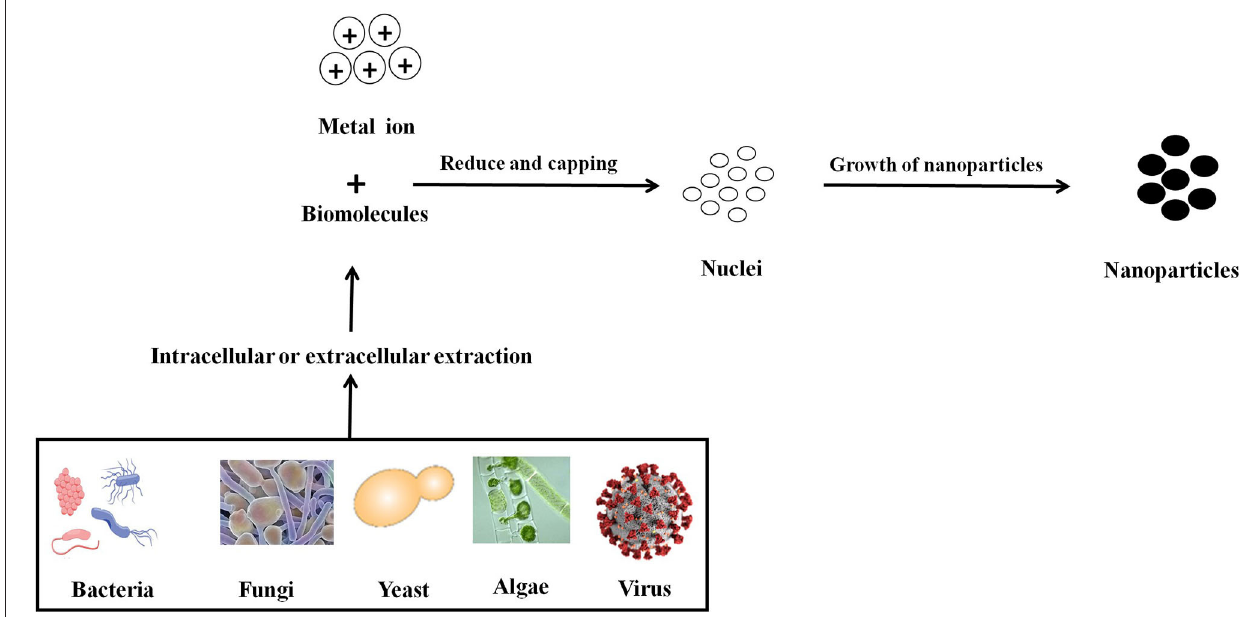
FIGURE 2 | Mechanistic representation of the synthesis of nanoparticle by microbes. Formation of nanoparticles by microbes involves metal capture, enzymatic reduction, and capping. Metal ions are first trapped on the surface or inside of the microbial cells and then reduced to nanoparticles in the presence of enzymes. The enzyme serves as the nucleation site, providing electrons to the metal for its reduction. Microorganisms can impact mineral formation through the production of organic polymers, which can impact nucleation by favoring (or inhibiting) the stabilization of the very first mineral